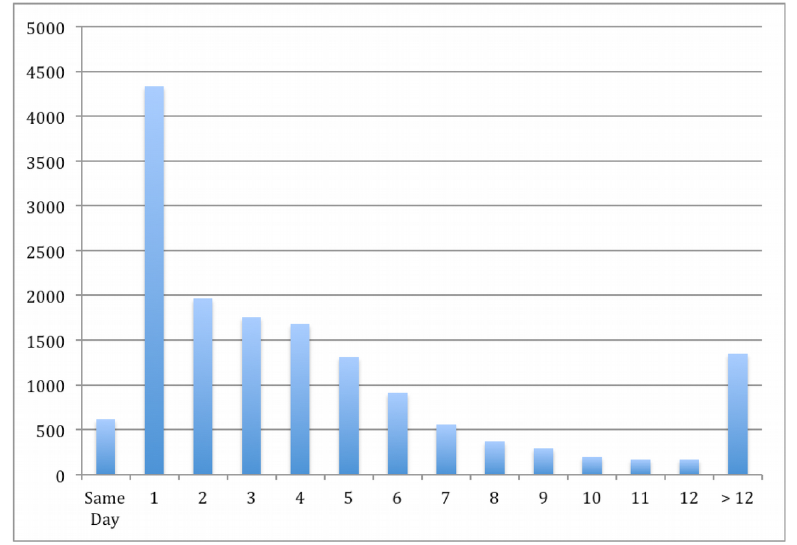
Figure 2. Plot of new patients’ appointment distribution by waiting time (in